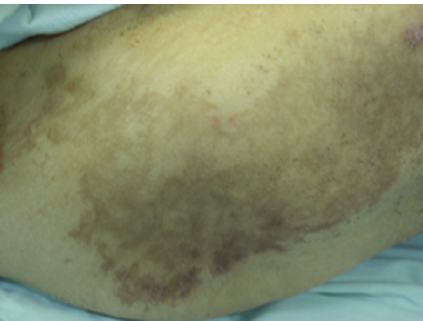
Figure 1: Necrolytic migratory erythema over the back with areas of healing and hyperpigmentation.